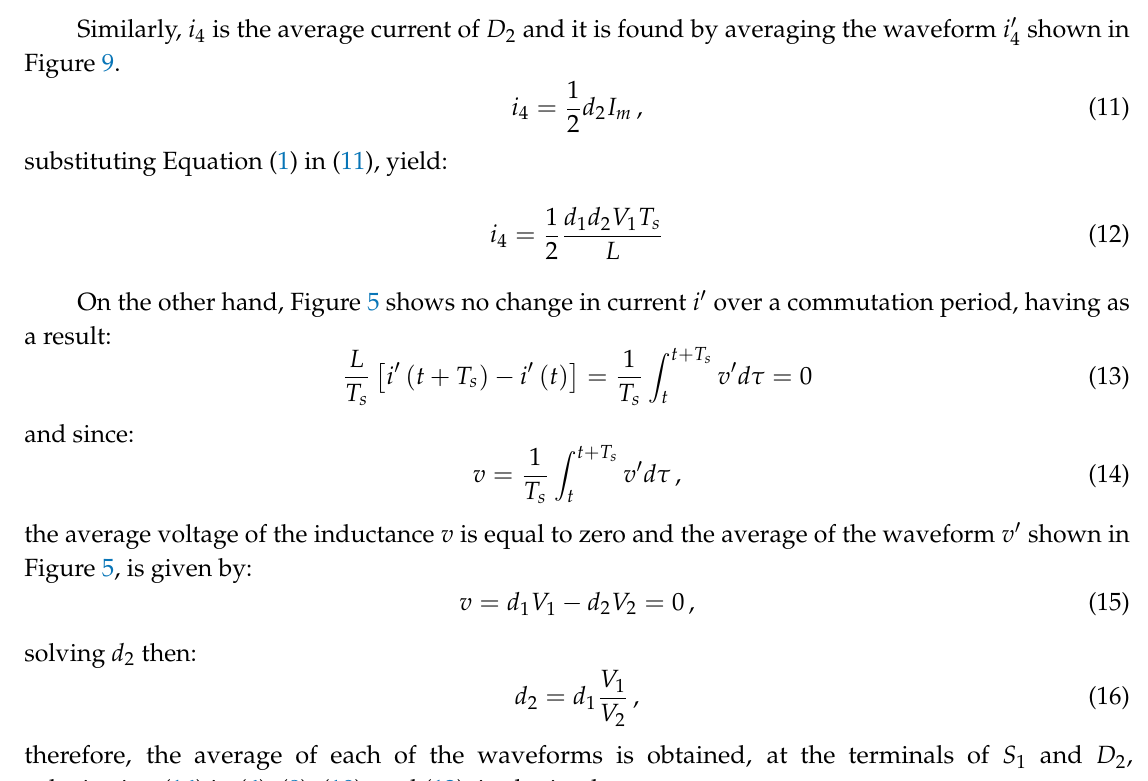
Figure 9. Voltage and current waveforms associated with D 2 for the equalizer circuit when V 1 > V 2